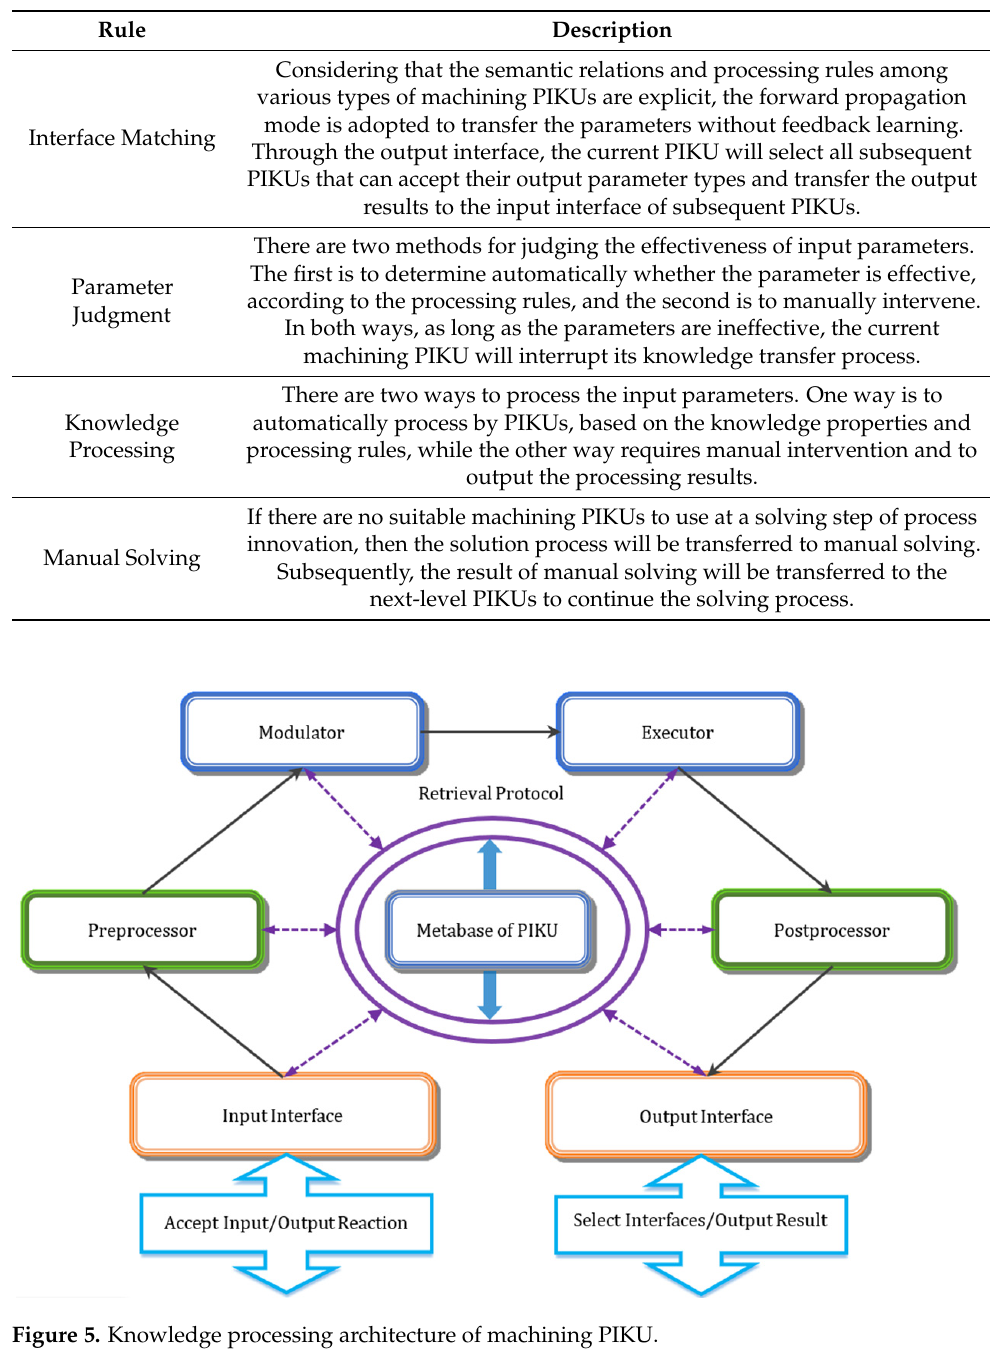
Table 3. The basic rules of knowledge-based heuristic machining process problem solving.